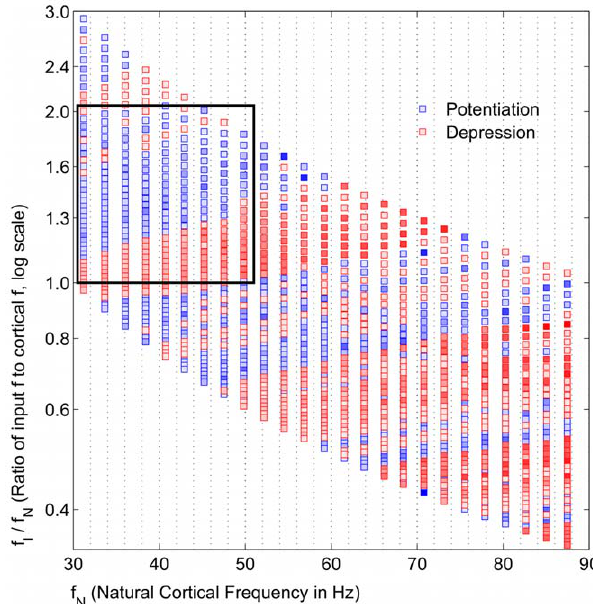
Figure 2. Frequency map shows broad bands of potentiation and depression that depend on f I . Distinct, broad bands of potentiation (blue) and depression (red) are interspersed for different natural network frequencies f N and input frequencies f I . The color intensities are normalized to the maximum absolute values of either potentiation and depression, respectively. The values are averaged around a window w ~ 100 ms around the peak value. Each frequency regime was simulated without noise in the input spiking. The rectangle denotes the frequency space with the broadest band of potentiation, which we predict is likely a physiological range of input and cortical network frequencies.